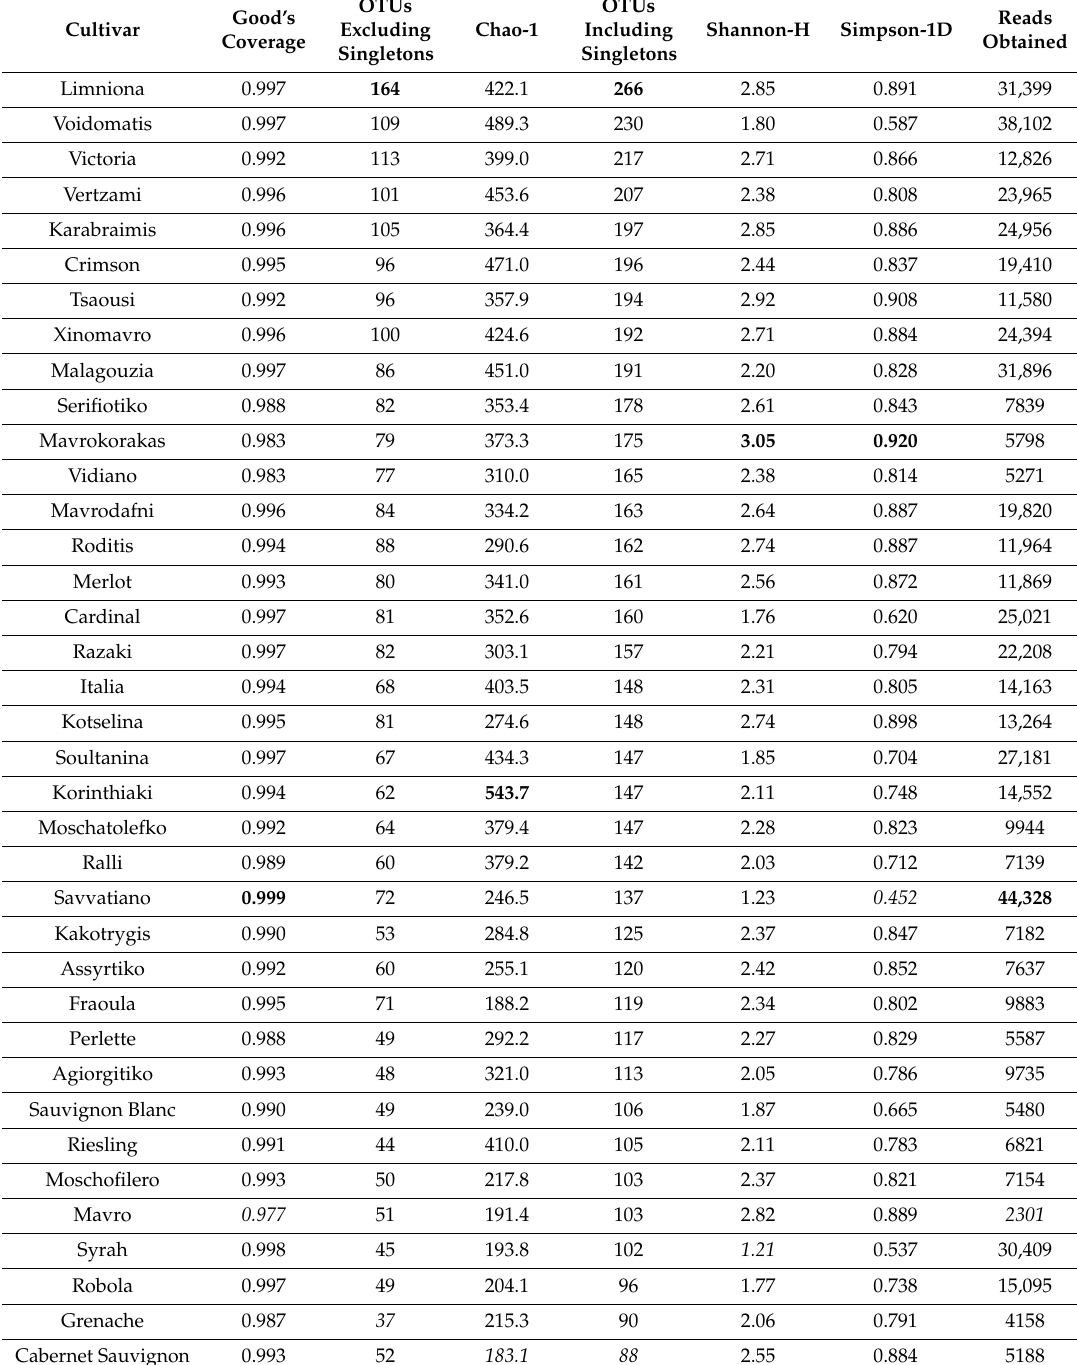
Table 2. The richness and diversity indices of bacterial communities among the studied grapevines. The highest values in each column are in bold and lowest in